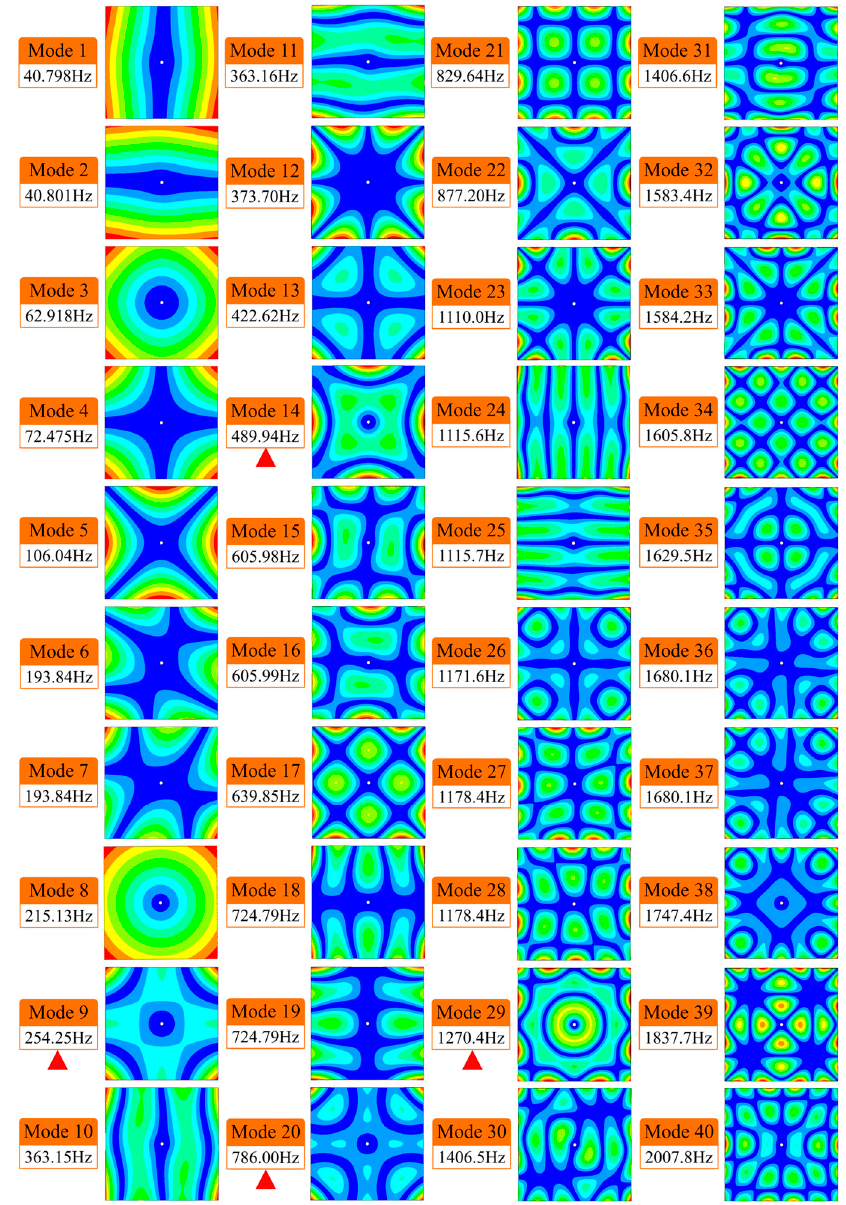
Figure 6. Natural frequencies and displacement mode shapes obtained by FE modal analysis.